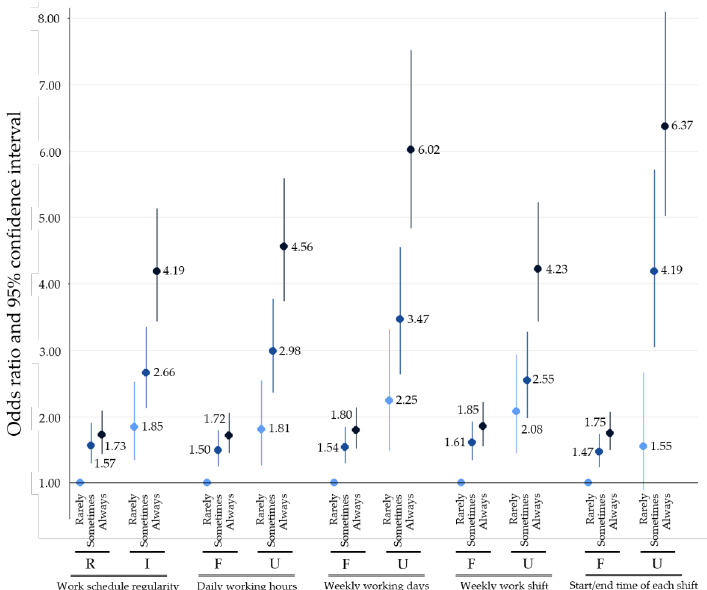
Figure 1. Odds ratios and 95% confidence intervals for moderate sleep disturbance according to work schedule regularity and frequency of emotion suppression at work. “R” stands for regular and “I” stands for irregular. “F” stands for fixed and “U” stands for unfixed. Regular work schedule indicates a schedule with fixed daily working hours, weekly working days, weekly work shift, and start and end time of each shift.